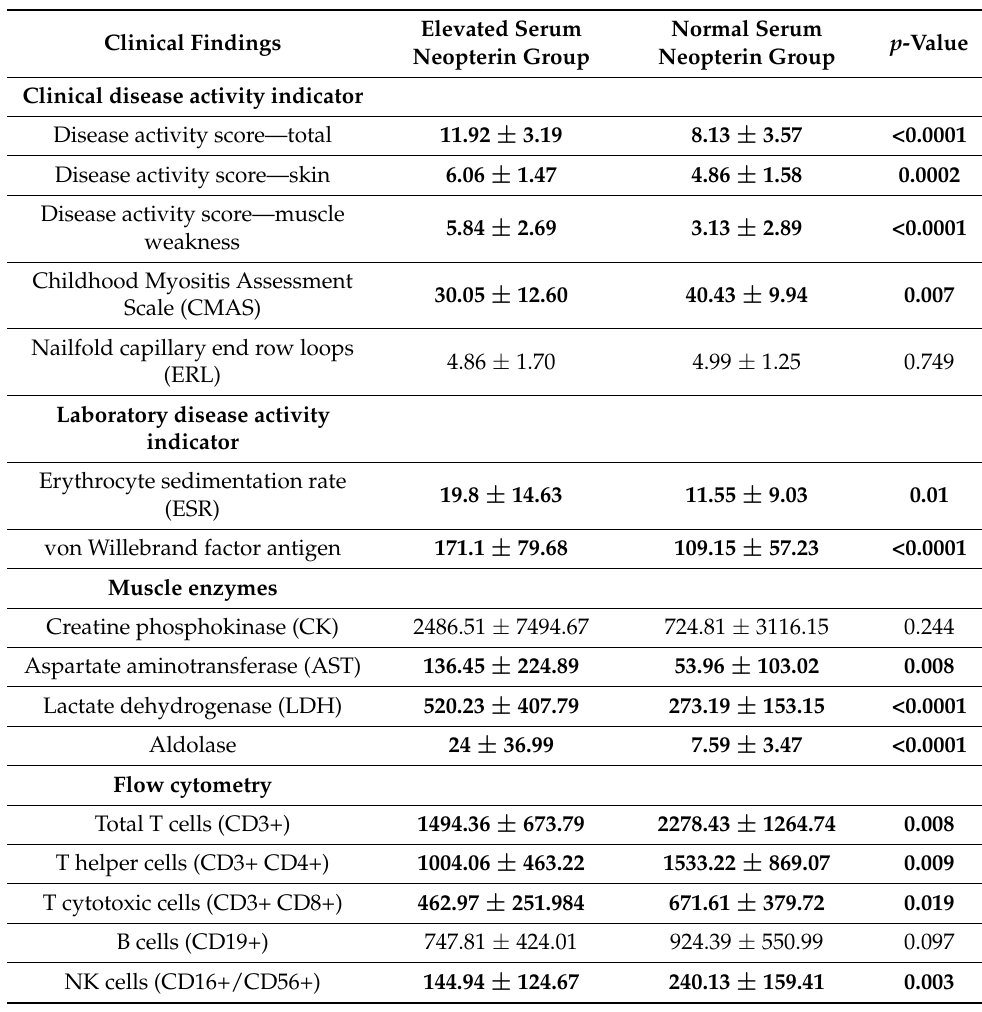
Table 2. Neopterin levels in 139 untreated children with JDM: disease activity markers and flow cytometry